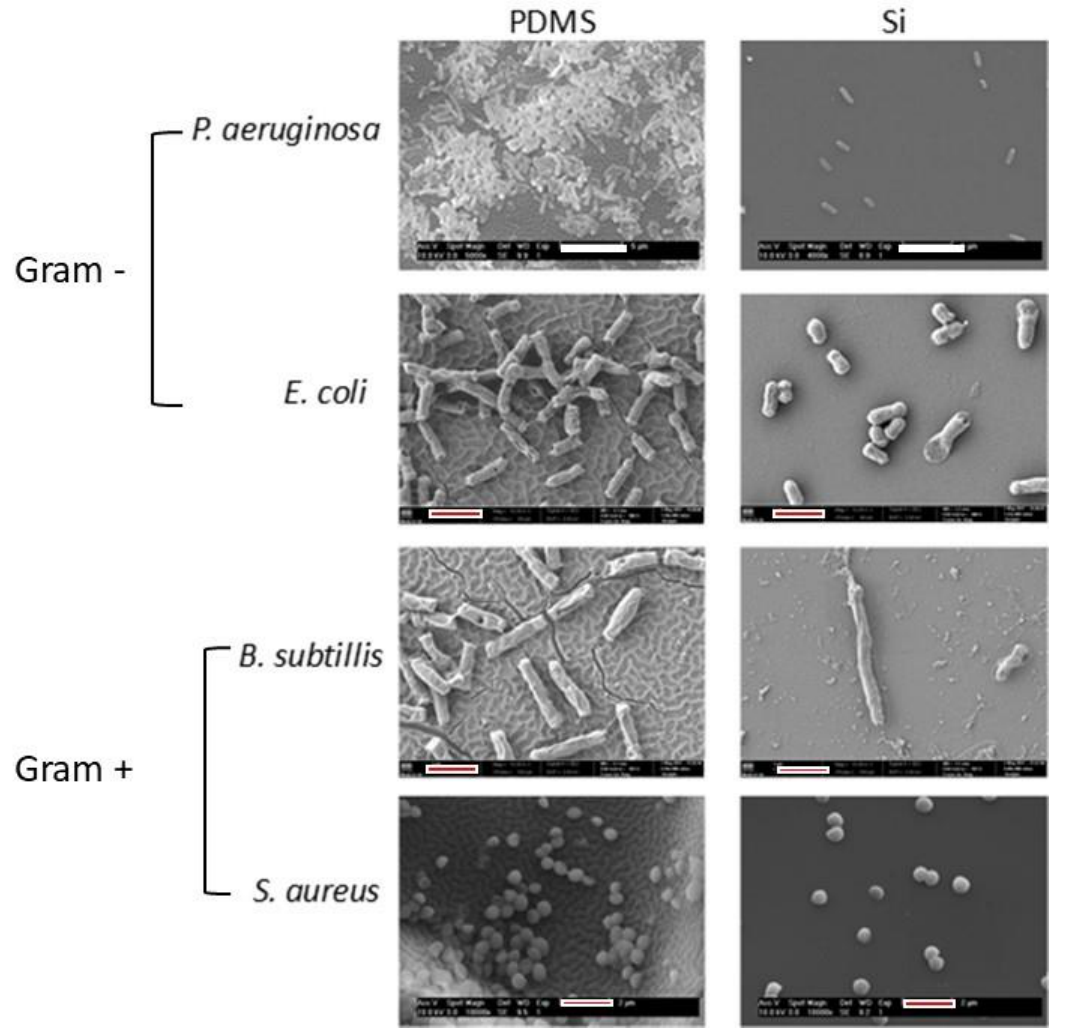
Figure 8. SEM micrographs of the N1 thin film deposited onto PDMS and Si after the growth-halo inhibition test (white bars = 5 m; red & white bars = 2 m).